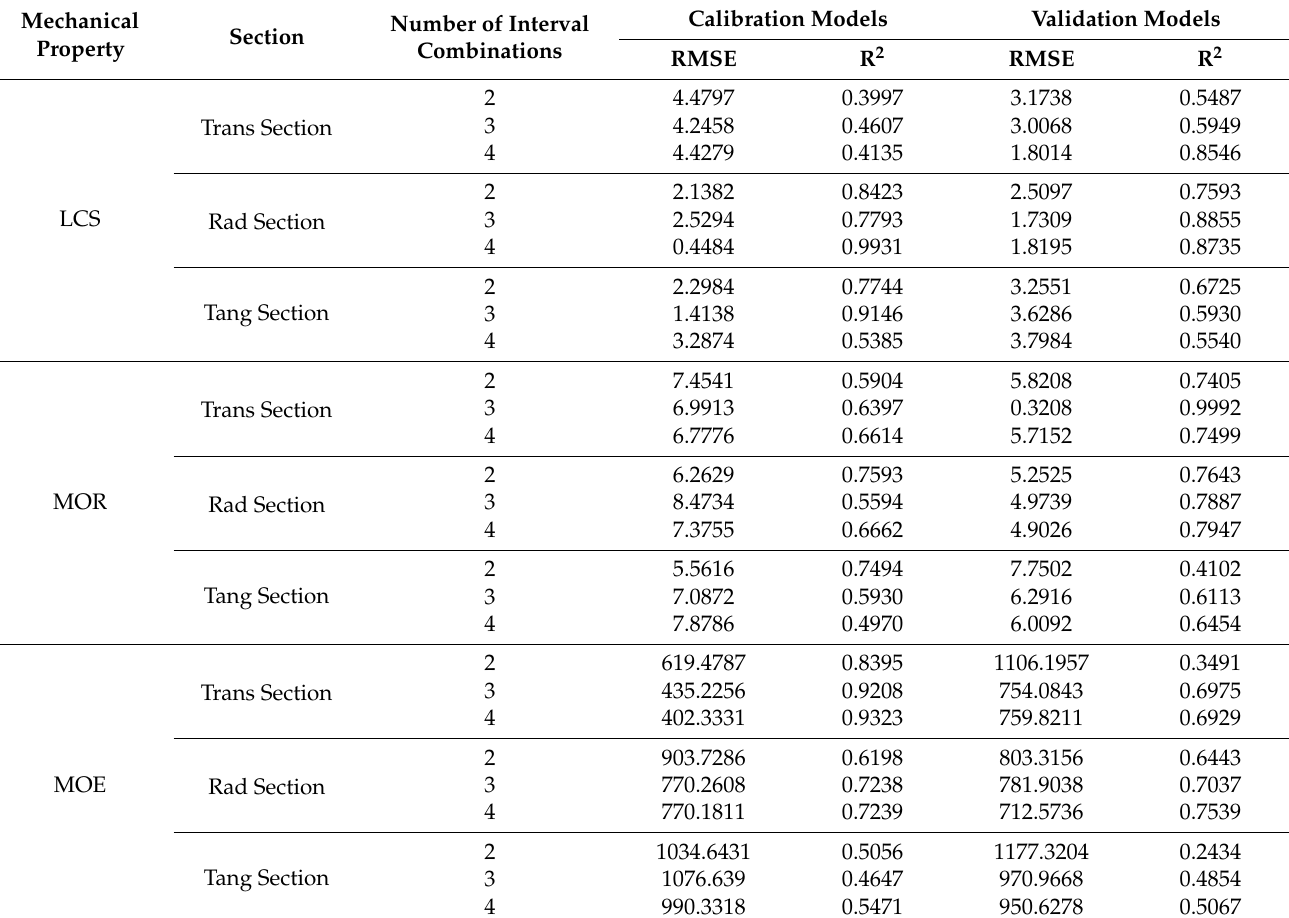
Table 4. PLSR modeling results based on SiPLS.